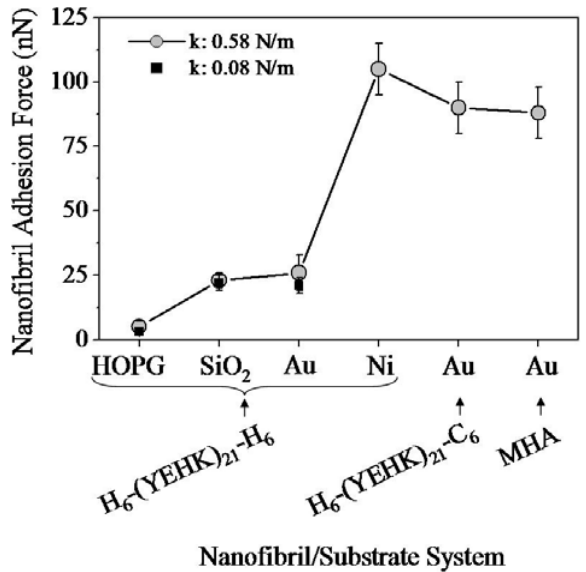
Figure 8. Summary of the normal spring forces required to displace both types of polypeptide and MHA material from the scan region on different